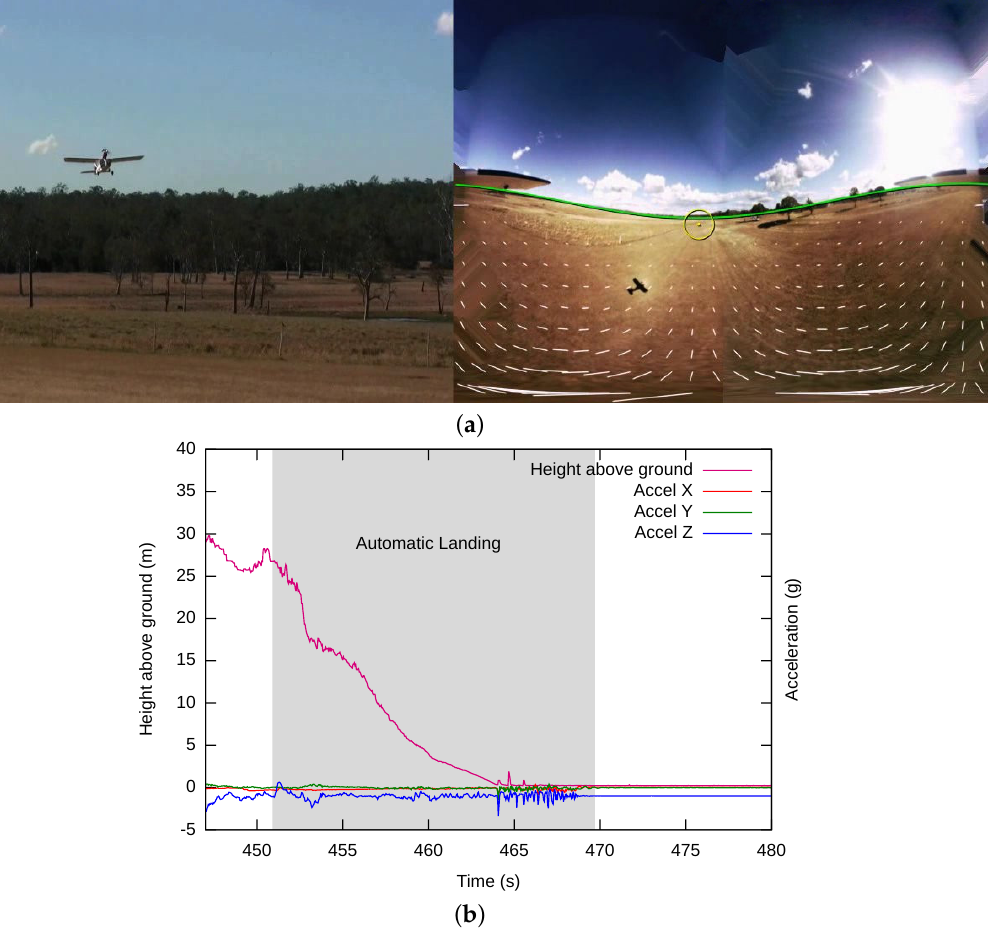
Figure 8. Automatic aircraft landing using optic flow and stereo. ( a ) External view (left panel) and panoramic image showing optic flow (right panel); ( b ) Performance of the automatic landing system, showing the variation of height with time (magenta), and the readings of the on-board X , Y and Z axis accelerometers (red, green and blue, respectively). The negative offset in the Z acceleration trace represents the acceleration due to gravity ( − 1 G). The first spike in the Z acceleration trace (at 308 s) represents the instant of touchdown, and the aircraft comes to a halt at the time when the signals from the accelerometers register zero (at 312 s). Reproduced with permission from